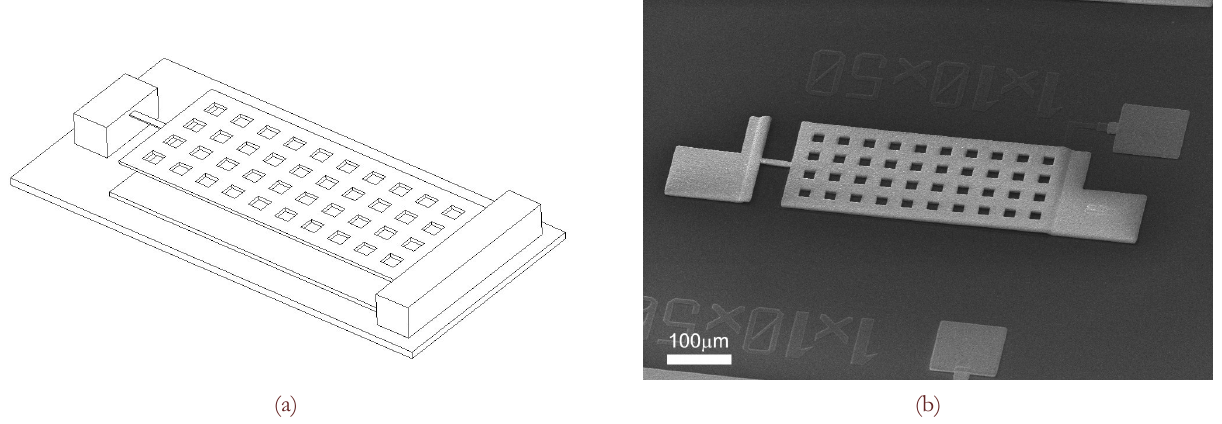
Figure 1: Geometrical shape of the testing device for shear and flexural fatigue loading with enlarged gap thickness (a) and SEM image of the actual device (b).